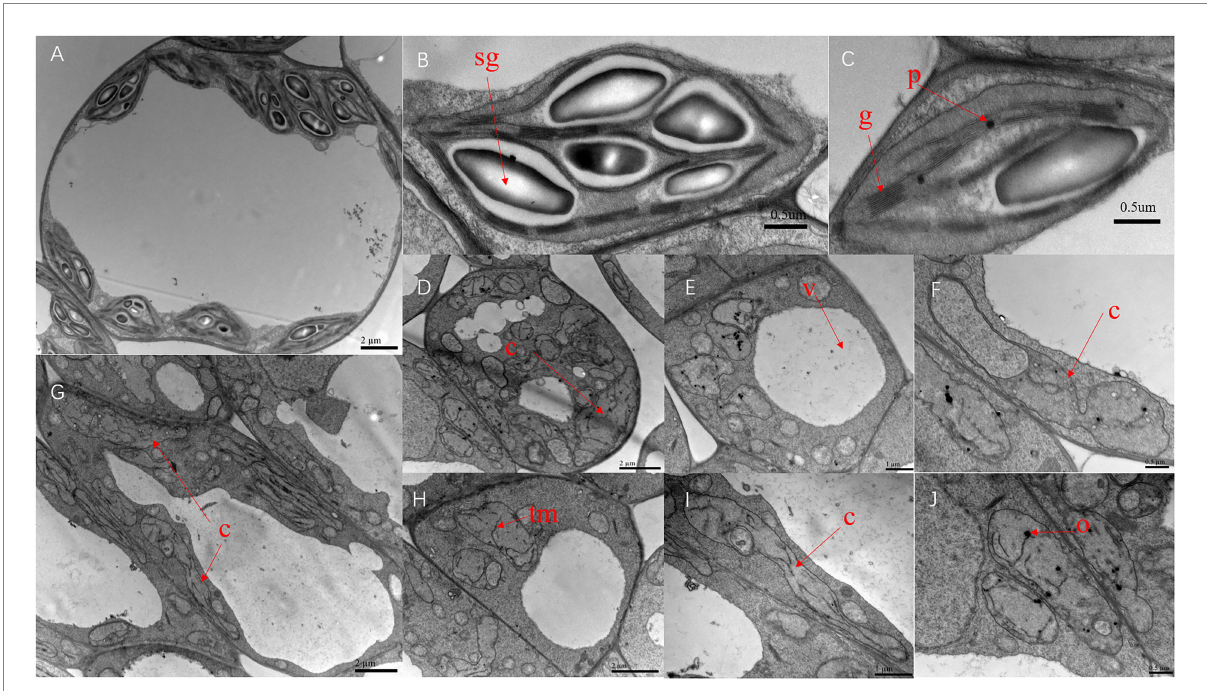
FIGURE 5 Transmission electron microscopy of the chloroplast ultrastructure of SC311 (A–C) and v-3 (D–J) . Sg, starch grain; G, grana; O, osmiophilic granule; TM, thylakoid membrane; V, vesicle; and C,